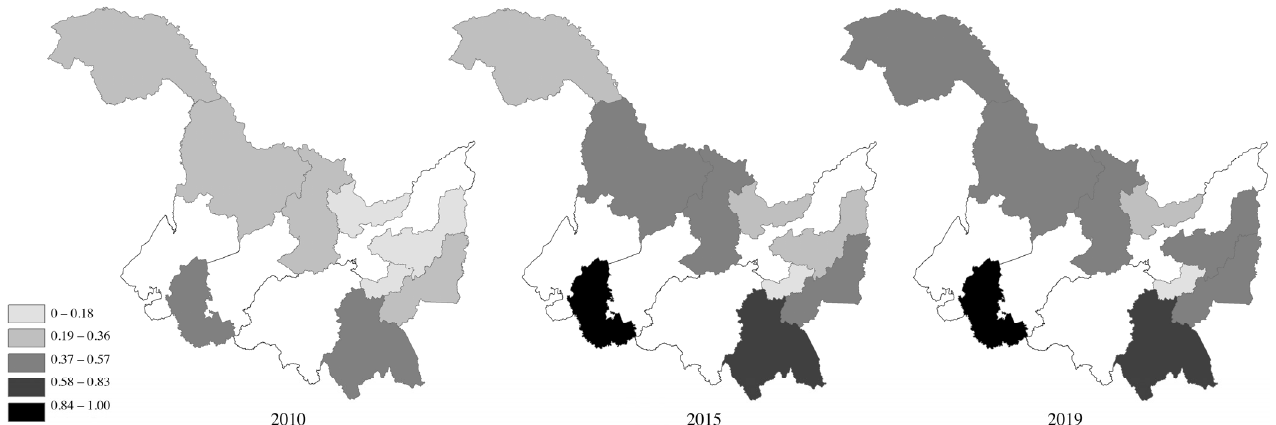
Figure 6. Spatial distribution of the overall resilience values of 9 RBCs.